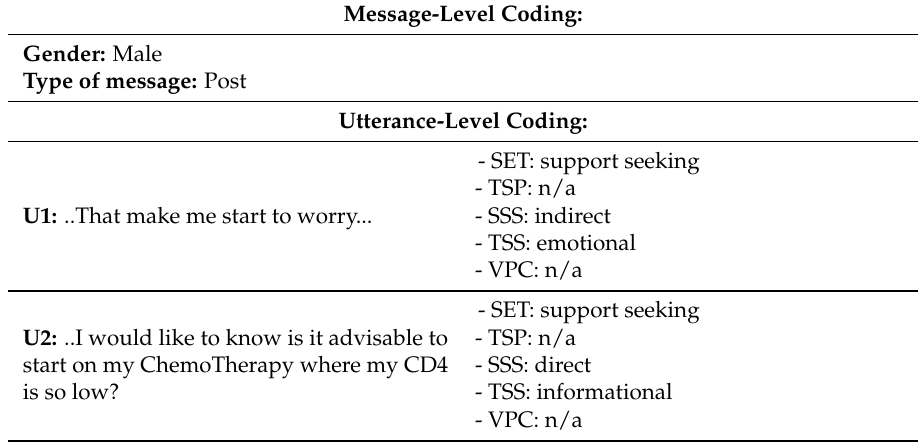
Table 3. Coding of a sample forum